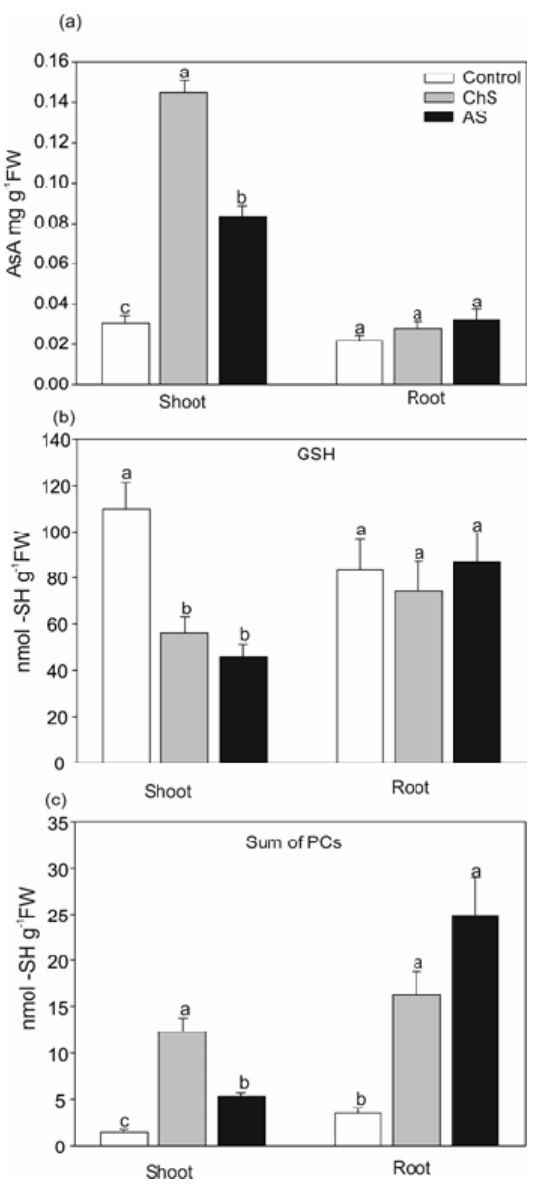
Figure 3. Effect of long-term chronic cadmium stress (ChS, 0.1 µM Cd, 85 days) or short-term acute cadmium stress (AS, 10 µM Cd, 4 days) on ( a ) ascorbic acid (AsA); ( b ) glutathione (GSH); and ( c ) sum of phytochelatins (PCs) content in the shoots and roots of C. acaulis . Data are means ± SE ( n = 5); values followed by the same letter are not significantly different ( p < 0.05, Tukey’s test). An increasing AsA level was determined in the shoots of plants exposed to ChS and AS (Figure